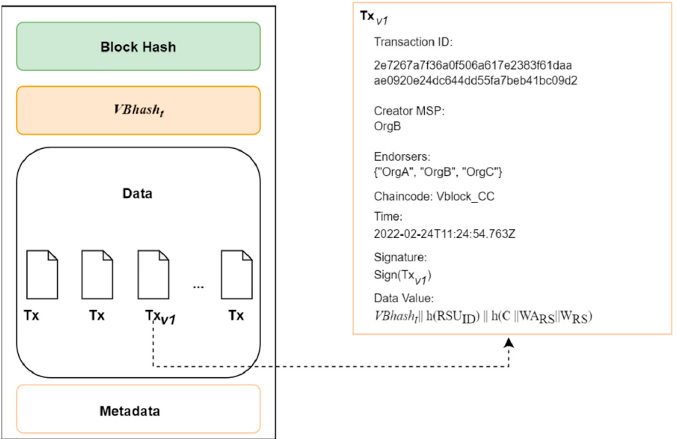
Figure 7. Transaction on the Hyperledger blockchain by the IoV node for outsourcing data.